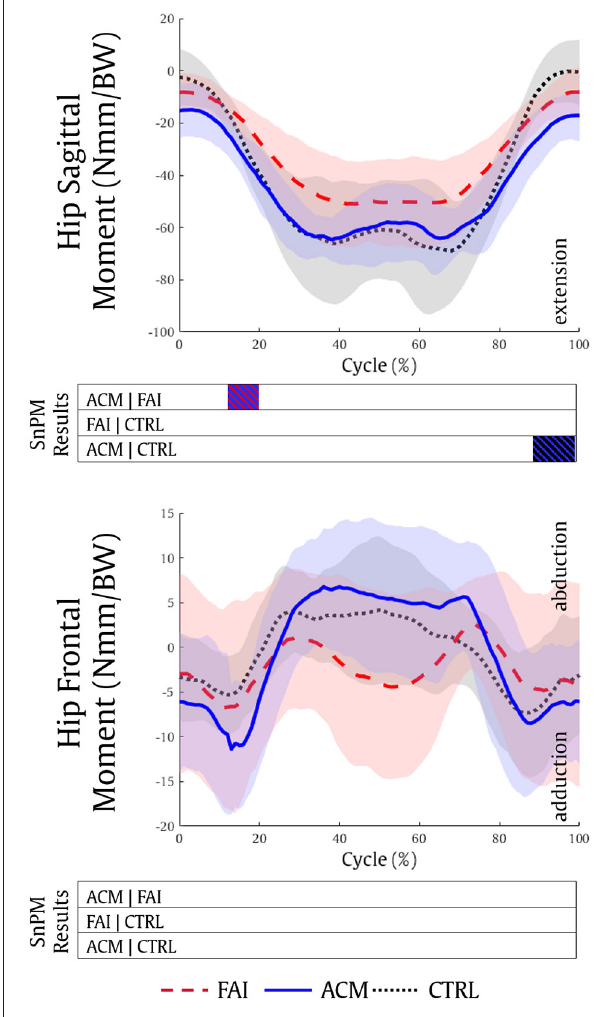
FIGURE 2 | Hip sagittal and hip frontal kinetics during the squatting task for the FAI (dashed red), ACM (solid blue), and CTRL (dotted black) groups. Positive values refer to hip flexion and hip abduction moments, respectively. SnPM results are displayed below the figure and indicate significant differences among the groups ( P ≤ 0.016). SnPM, statistical non-parametric mapping; BW, body weight; FAI, femoroacetabular impingement; ACM, asymptomatic cam morphology, CTRL, control. Shading indicates standard